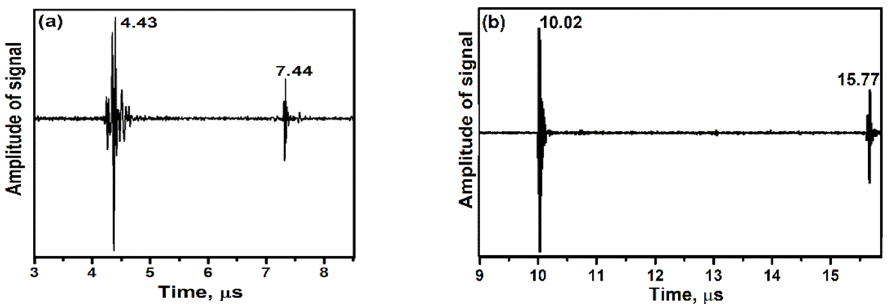
Figure 7. Recorded signals extracted via ( a ) longitudinal waves and ( b ) transverse waves of CaTiO 3 specimen.